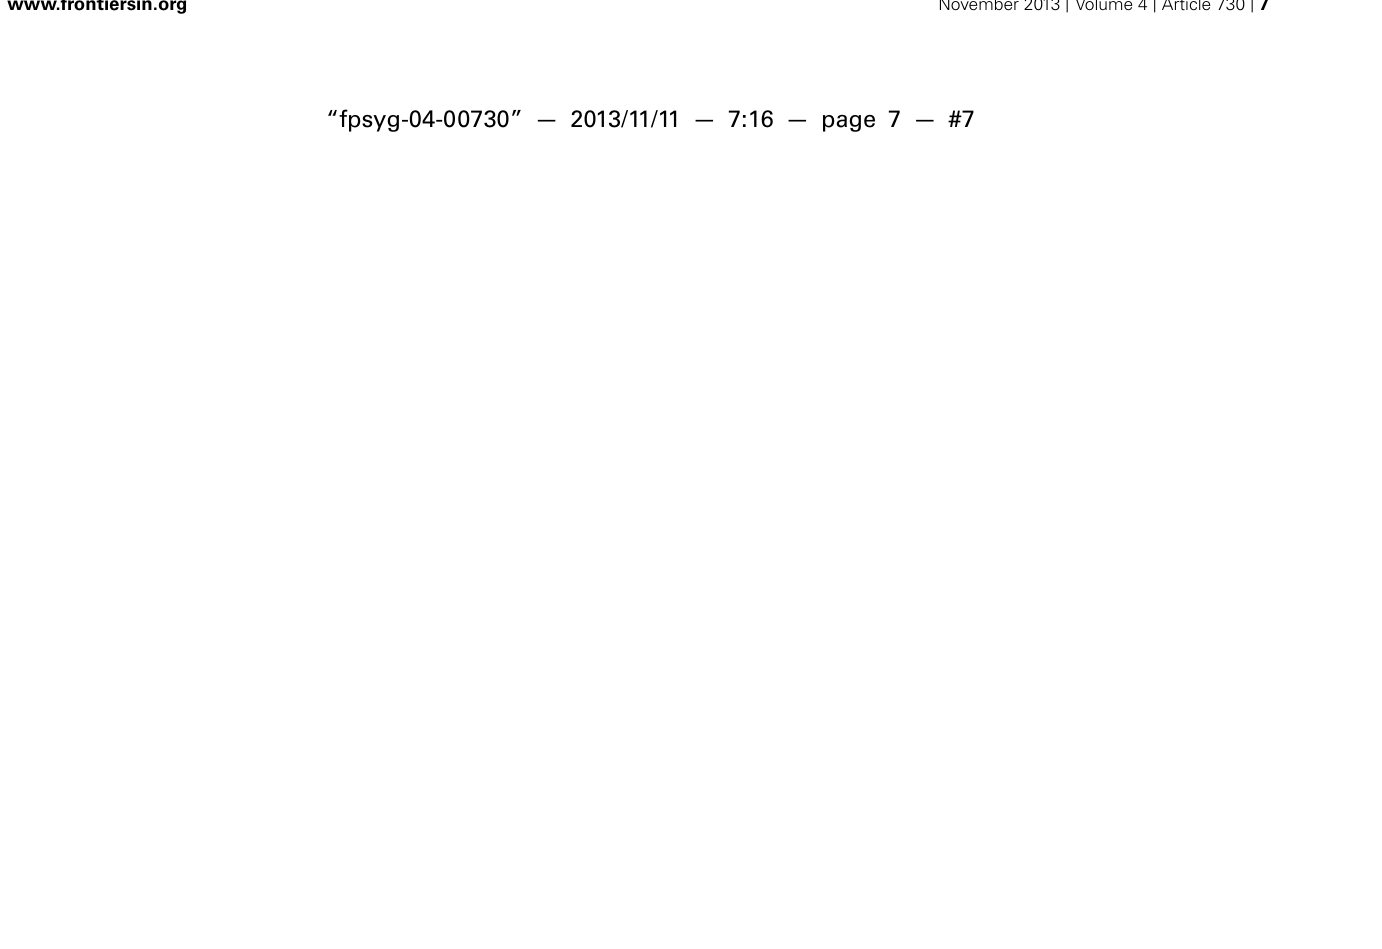
notobservedforparticipantsinthelowstressgroup, t (23) = 0.882, p = ns,